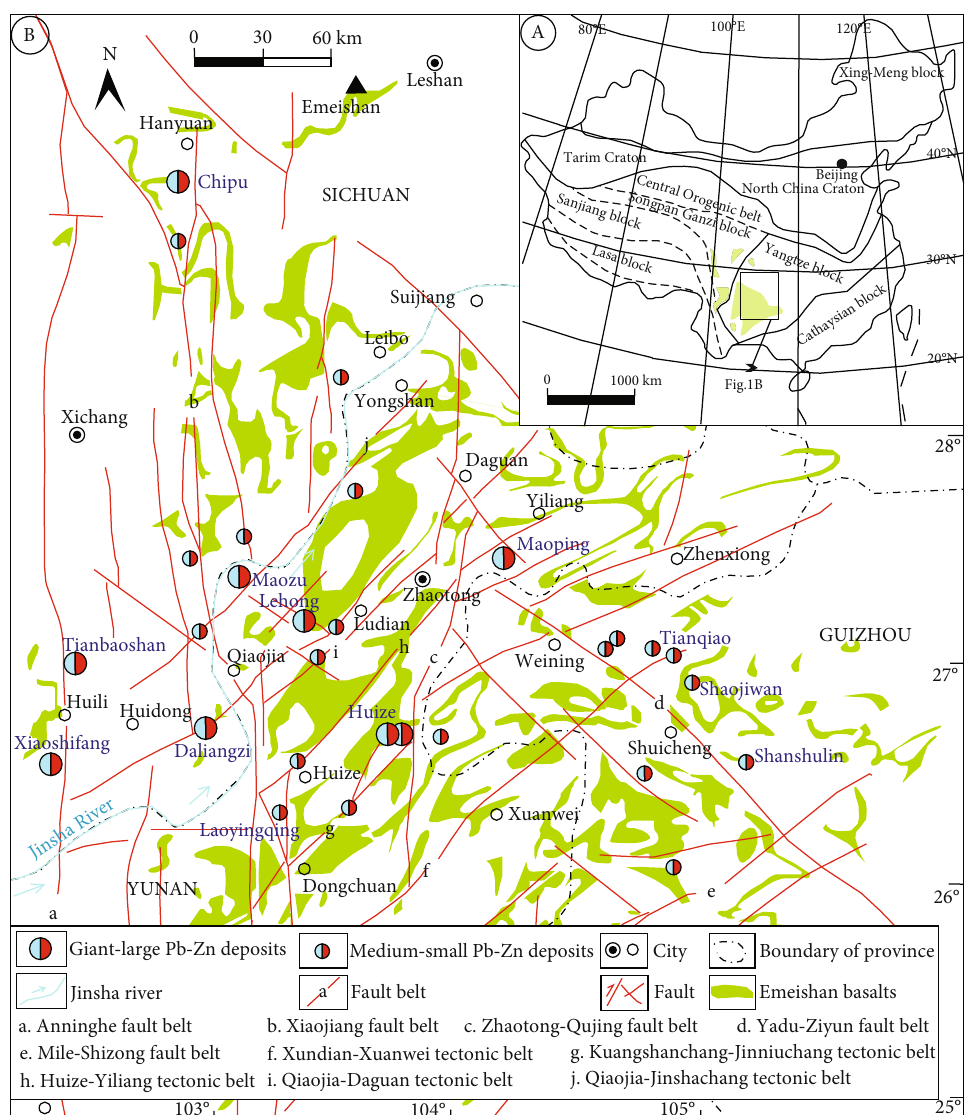
Figure 1: Regional geological map. Panel A: simpli fi ed tectonic map of South China (after [7, 31]). Panel B: regional geological map of the SYGT, SW China, showing the spatial relationships among the fault belts, Emeishan basalts, and major Pb – Zn deposits (modi fi ed from